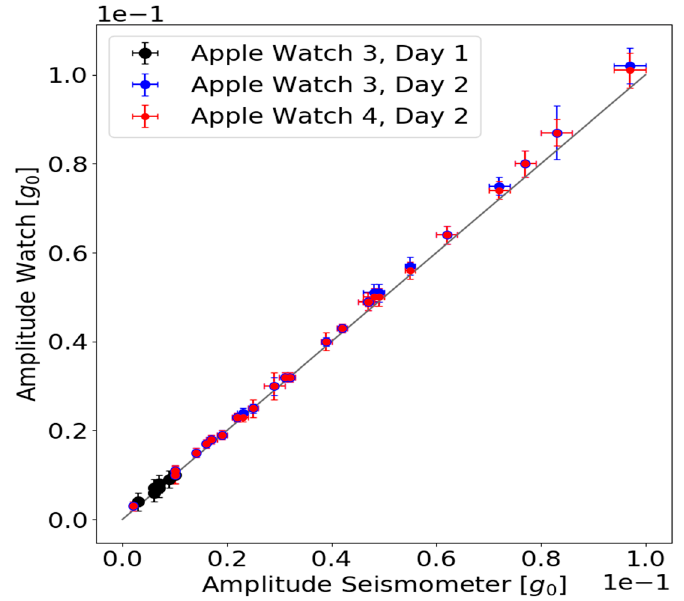
Figure 6. Measured oscillation amplitude of the seismometer and the watches are plotted against each other. The standard deviations of the amplitude mean values are plotted as error bars (horizontal error bar: seismometer values, vertical error bar: watch values). The grey line corresponds to a perfect agreement between the oscillation amplitude measured by the watches and the seismometer.